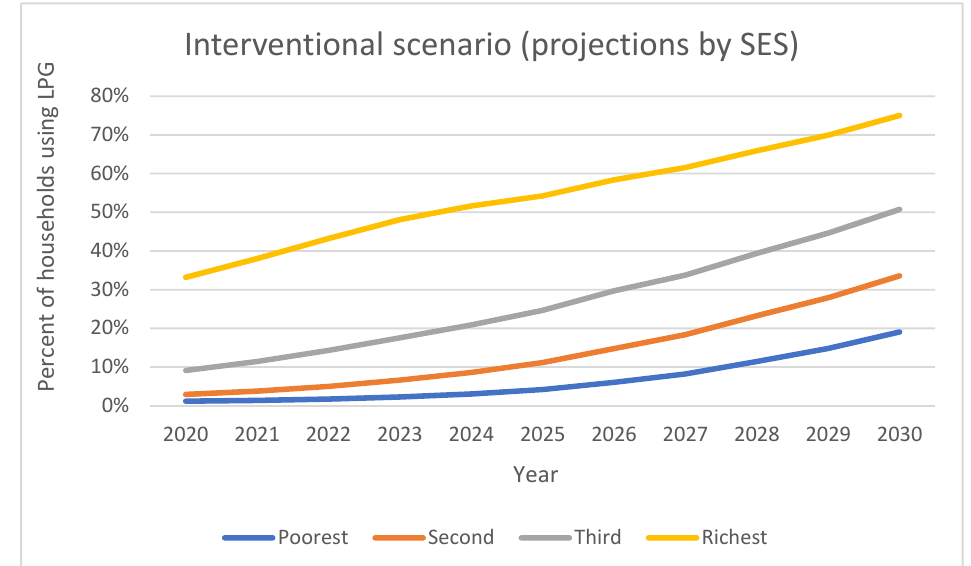
Figure 2. Projected LPG household adoption by socio-economics status (Ubudehe) categories.